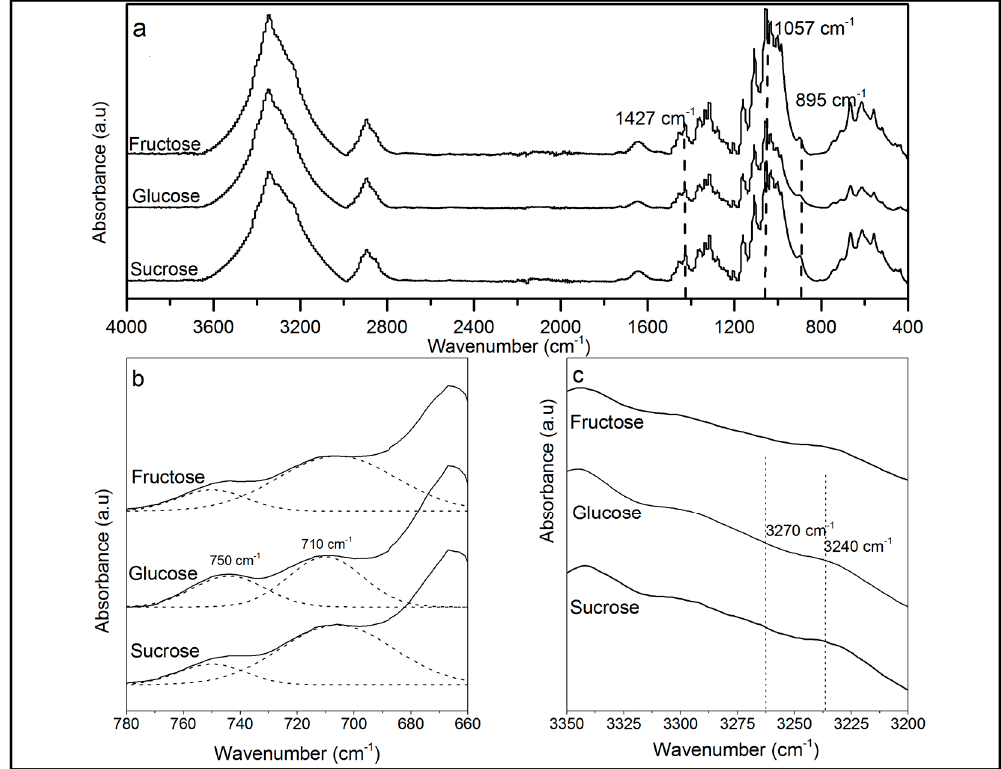
Figure 6. ATR-FT-IR spectra of bacterial cellulose produced in each media: ( a ) complete spectra; ( b ) characteristic bands at 710 cm − 1 and 750 cm − 1 ; and ( c ) characteristics band at 3240 cm − 1 and 3270 cm − 1 . Straight line: fragment original spectra; dotted line: deconvolution. Table 3. I α fraction estimation in each BC produced from the evaluated culture media.